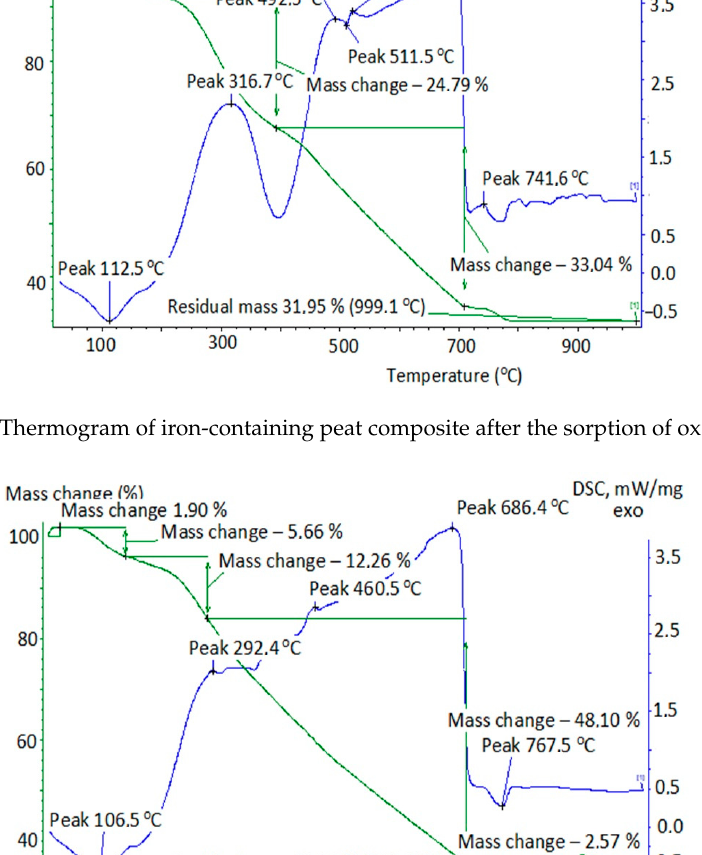
Figure 3. Thermogram of iron-containing peat composite after the destruction of oxalic acid under UVI + H 2 O 2 . Table 2. Data on the changing of iron-containing peat composites at their thermal destruction, depending on the conditions of oxalic acid removal from the model